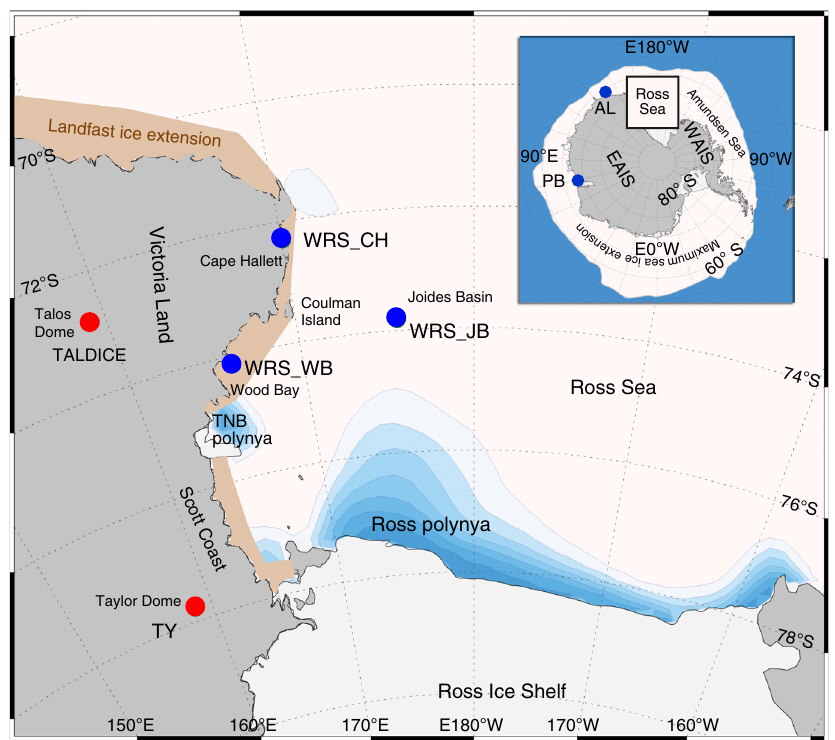
Fig. 1 Location of the studied marine and ice core sites in the WRS area. The TALDICE and Taylor Dome (TY) ice cores and the Joides Basin (WRS_JB), Cape Hallett (WRS_CH) and Wood Bay (WRS_WB) sediment cores are indicated in the map. The Ross Sea and Terra Nova Bay (TNB) latent-heat polynyas (from cyan to blue, % of open water from May to November) and present day landfast ice extension area (brown) are schematically represented. The inset shows a map of Antarctica with the location of the other marine cores cited in the text and retrieved in the Adélie Land (AL) and Prydz Bay (PB) 38 . East Antarctica ice sheet (EAIS), West Antarctica ice sheet (WAIS) and the maximum Antarctic winter sea ice extent is